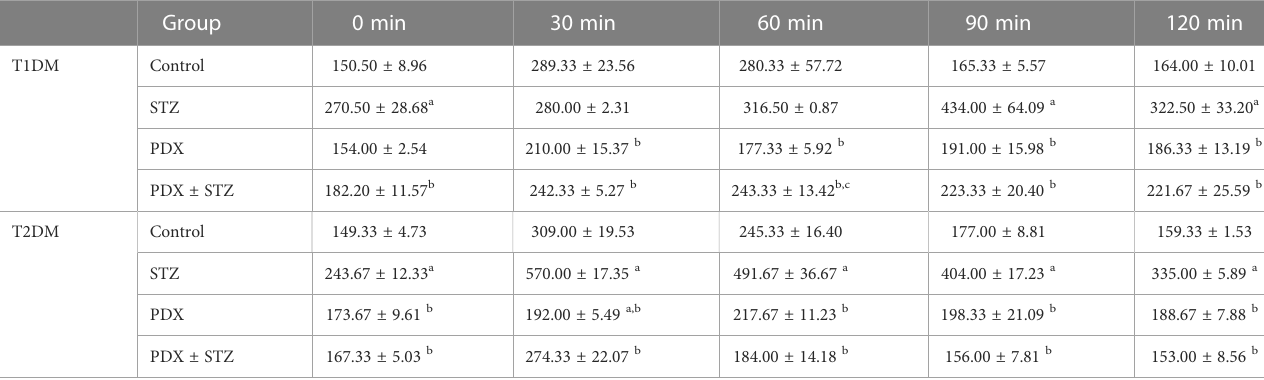
TABLE 3 OGTT in STZ-induced Type 1 DM and Type 2 DM mice.